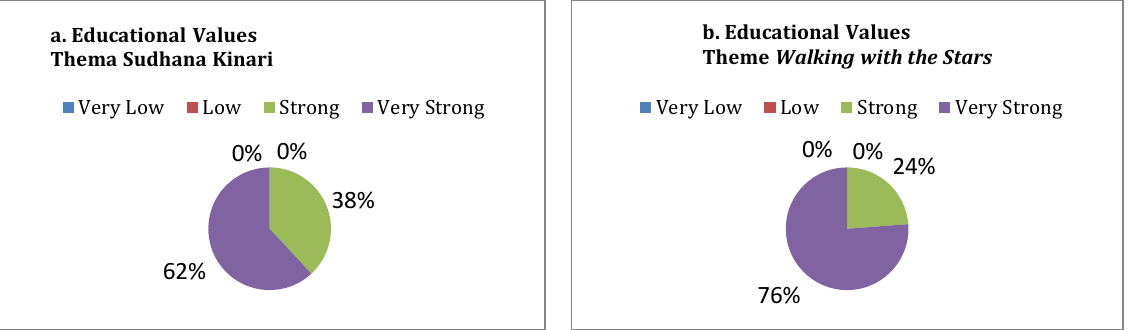
Fig. 5 Educational Value Theme 1; a Sudhana Kinari , b Walking with the Stars